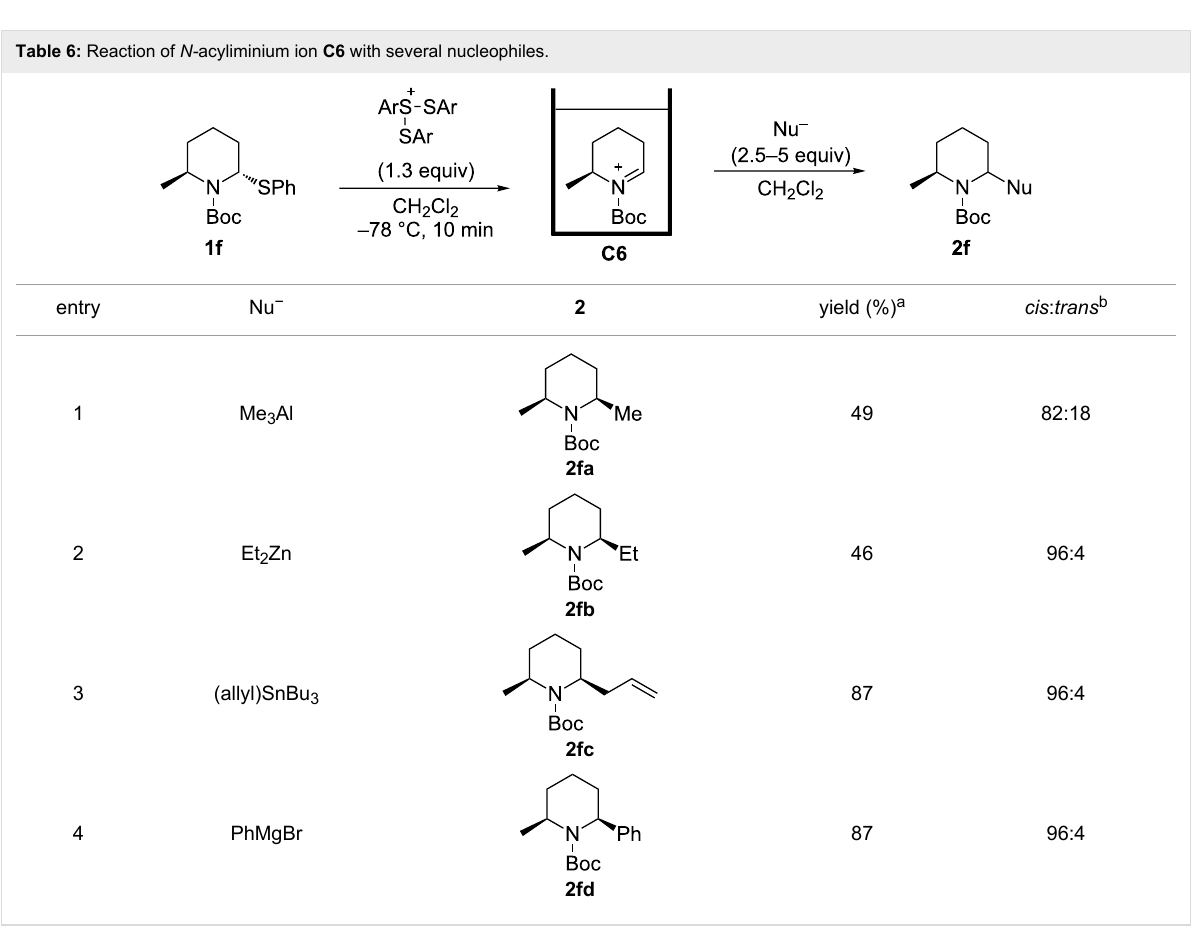
Table 6: Reaction of N- acyliminium ion C6 with several